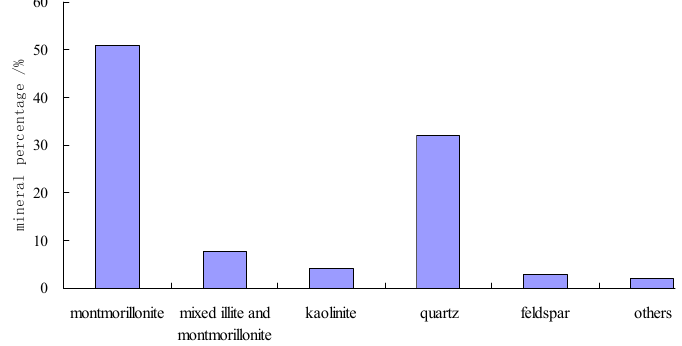
Figure 5. Mineral composition of expansive soil sample. According to the measured expansive force under different initial water contents in Figure 2, the equivalent expansion force was obtained by finding and determining the maximum expansion force, and the relation curve between the equivalent expansive force ( p s )and initial water content ( w ) is illustrated in Figure 6.